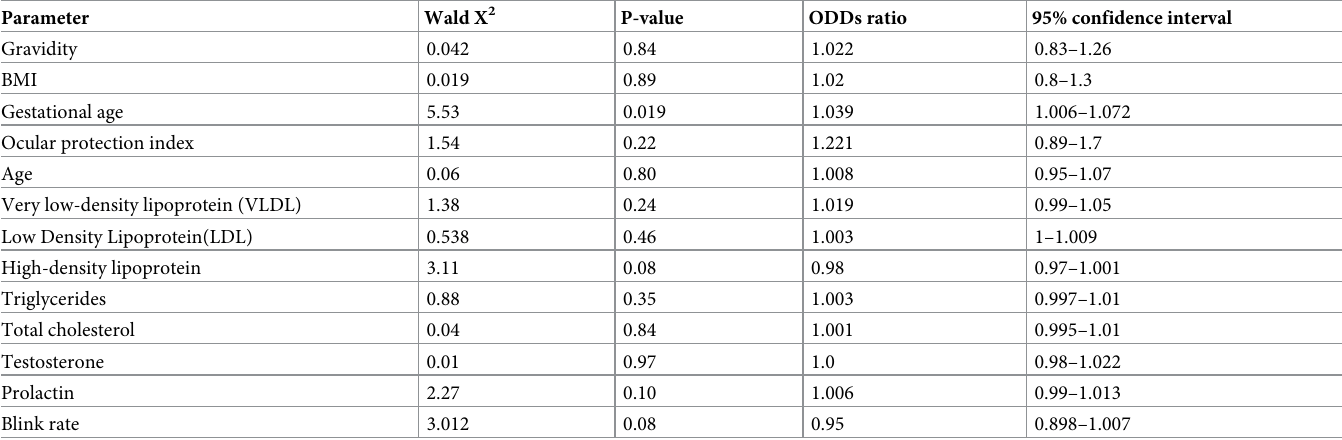
Table 2. Univariate binary logistic regression analysis.